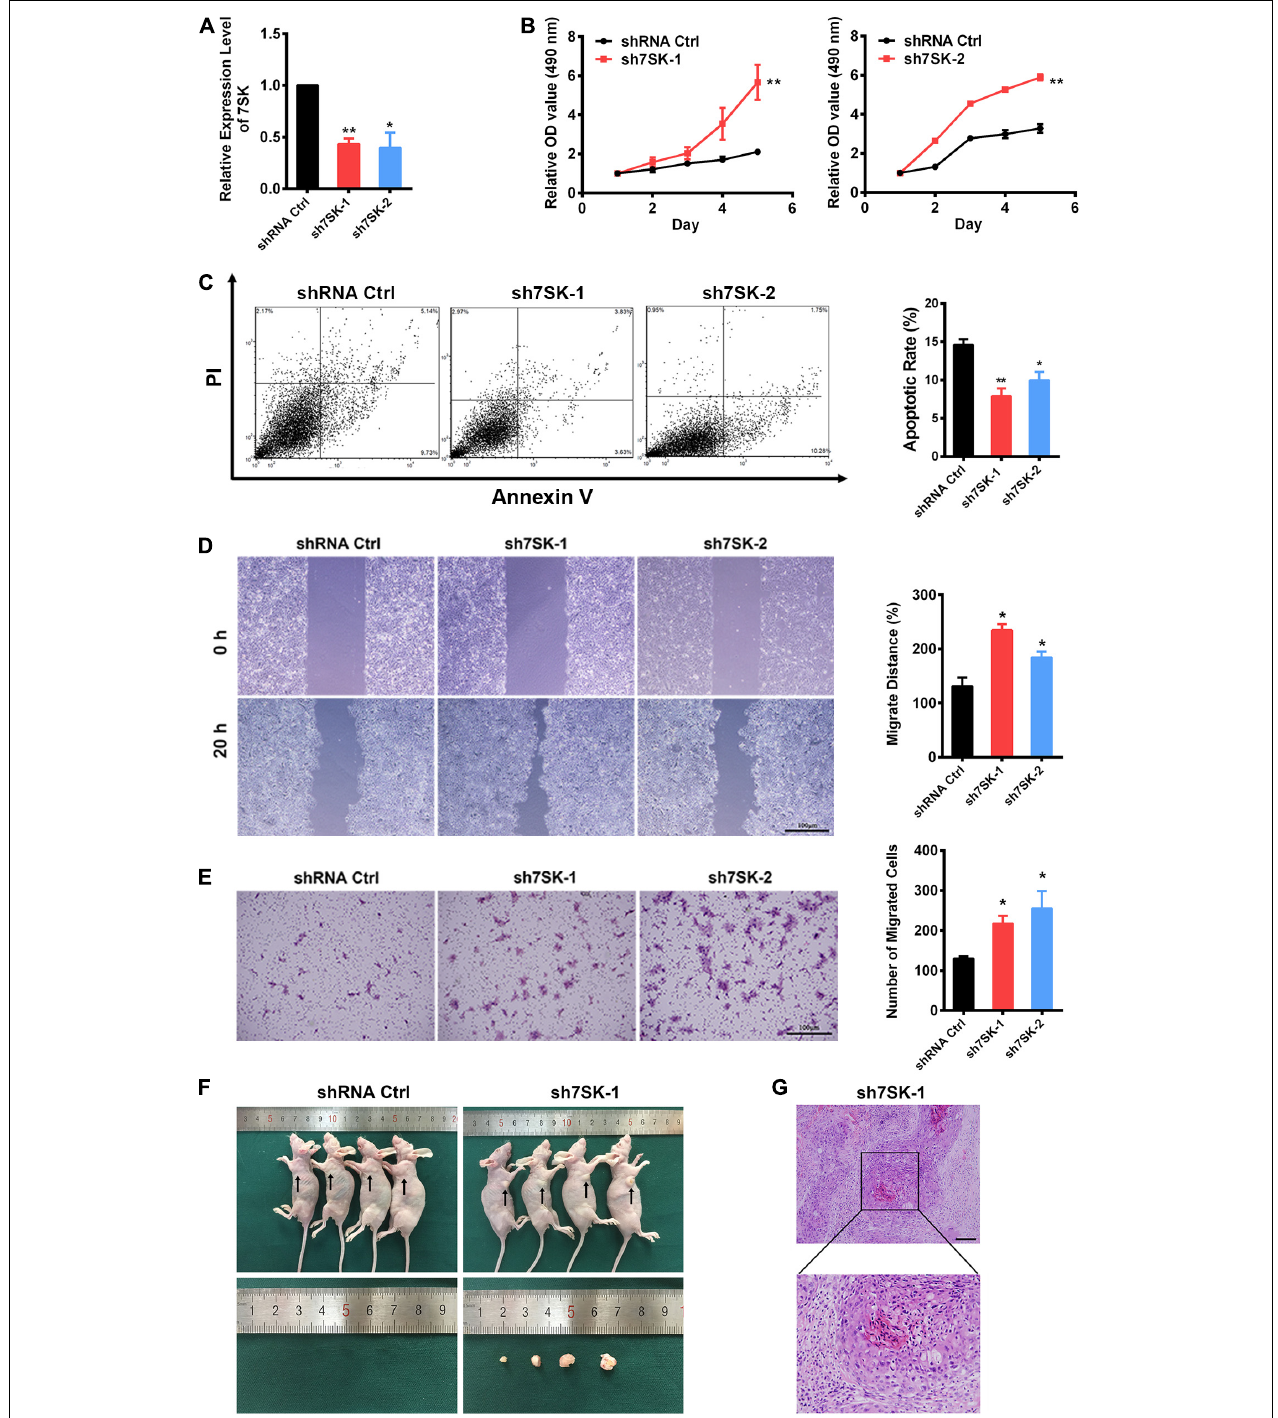
FIGURE 2 | 7SK inhibits tumor progression in vitro and in vivo . (A) Efficiency of 7SK knockdown in SCC15 cells, n = 3. (B–E) Apoptosis assay detected by Annexin V/PI staining (B) , MTS assay (C) , wound healing assay (D) , and transwell assay (E) in 7SK knockdown SCC15 cells, n = 3. For (C–E) , the representative images and corresponding statistical analysis are shown. The scale bar is 100 µ m. (F) Images of nude mice injected with control or sh7SK-1 SCC15 cells, as well as the lumps from the injection of sh7SK-1 SCC15 cells. (G) HE staining of lumps from sh7SK-1 SCC15 cells injection, n = 4. The scale bar is 50 µ m. Data represent the mean ± SEM. * P < 0.05. ** P <